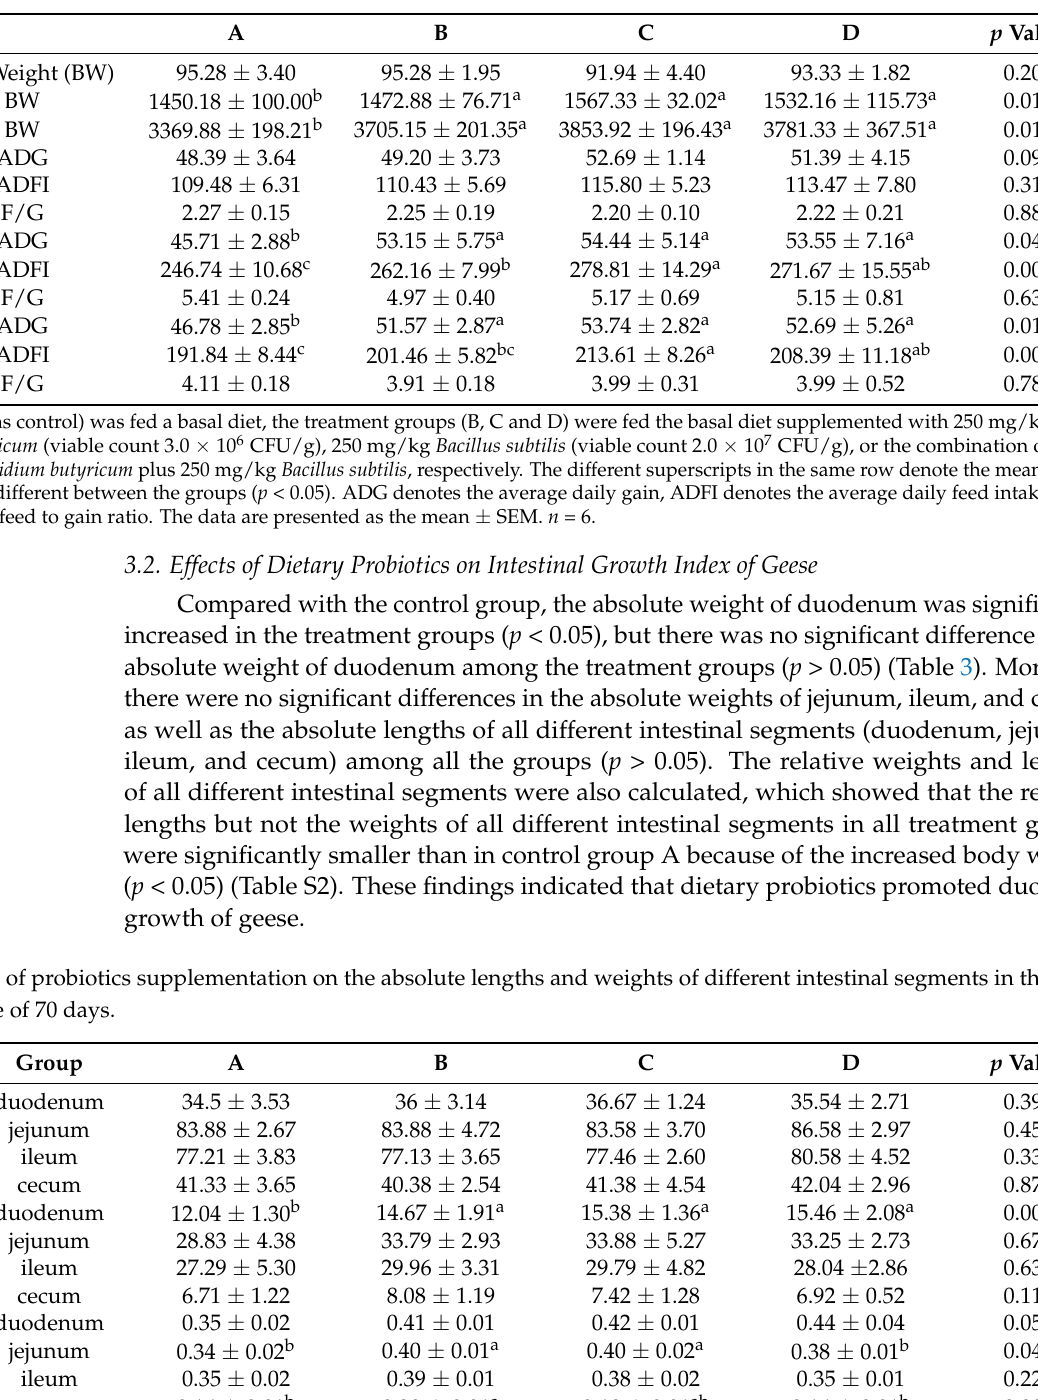
Table 2. Effects of probiotics supplementation on goose production performance.